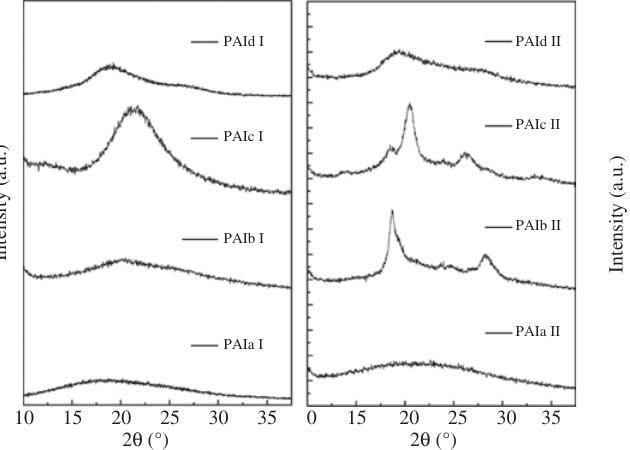
Figure 8: Wide-angle X-ray diffractograms of PAIc I1h.